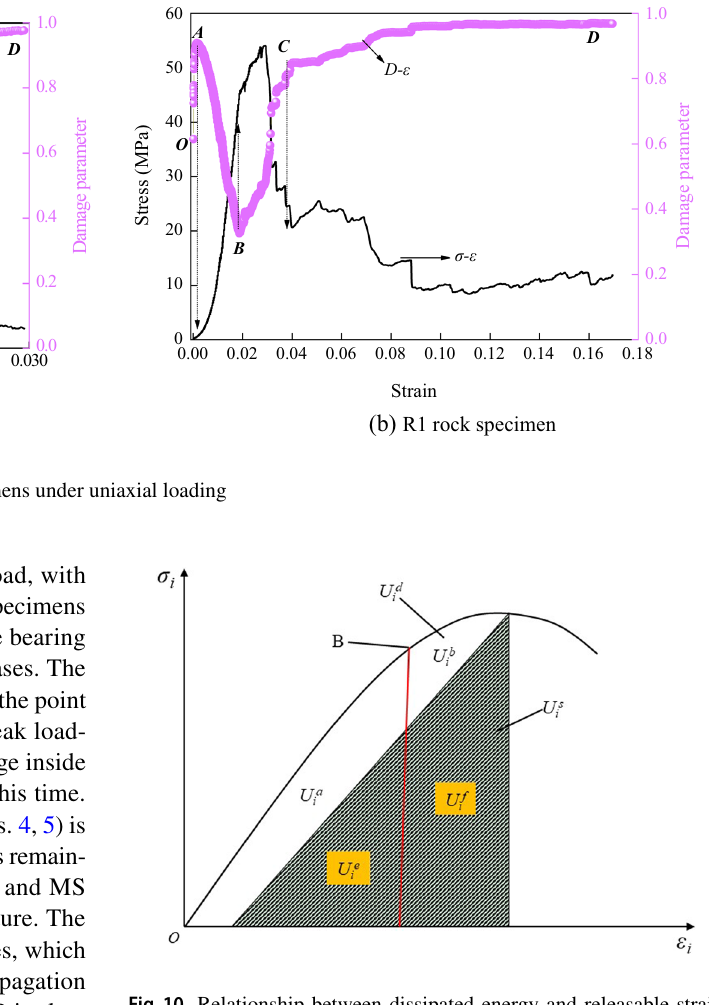
Fig. 10 Relationship between dissipated energy and releasable strain energy of coal and rock under loading (Xie et al.